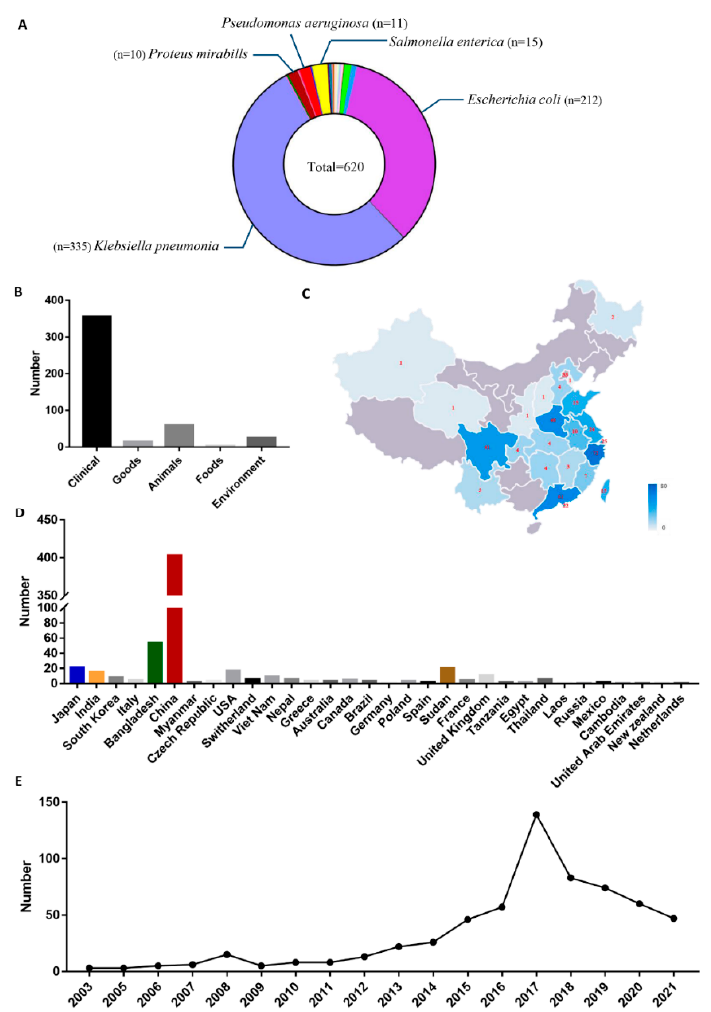
Figure 4. Prevalence and distribution of rmtB -positive isolates. ( A ) Species classification of rmtB positive isolates. ( B ) Source statistics of rmtB -positive isolates ( C ) Geographical distribution of rmtB -positive isolates in China. The color depth correlates with the quantity. ( D ) Distribution of rmtB -positive isolates worldwide. ( E ) Isolation of rmtB -positive isolates from 2003 to 2021. From another perspective, these rmtB -carrying strains were isolated from 32 different countries, with the largest total number of strains isolated from China (Figure 4D, Table S5). From 2003 to 2022, rmtB -carrying strains were isolated from 24 provinces or regions in China; they were highly prevalent in Zhejiang (17.9%), Guangdong (15.2%), Sichuan (10.22%), and Henan (11.97%) provinces (Figure 4C, Table S5). According to the